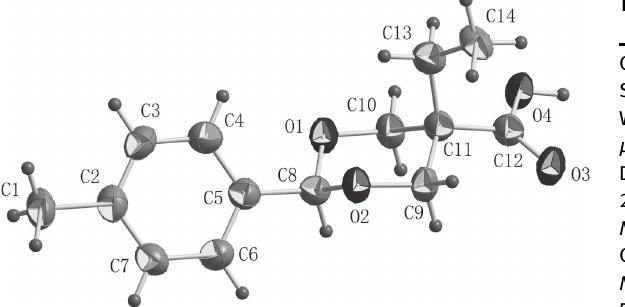
Table 1: Data collection and handling.